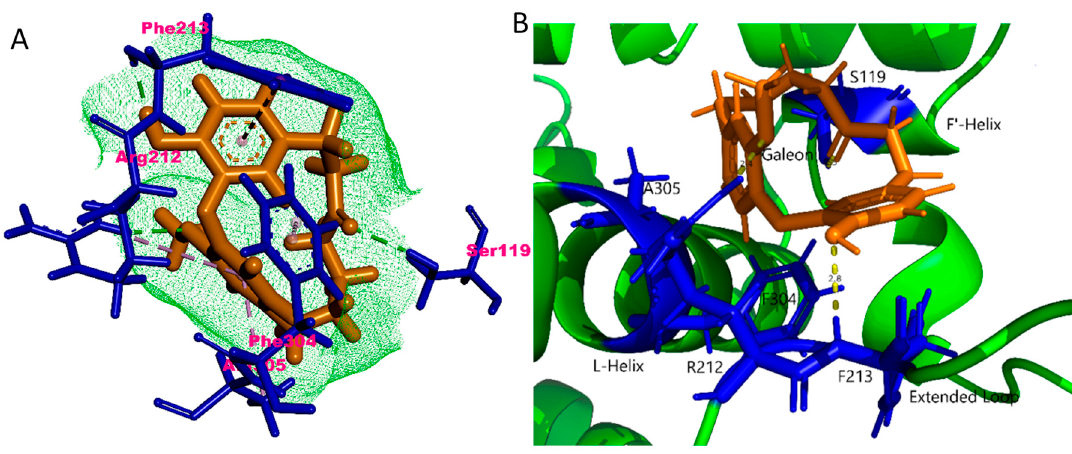
Figure 9. ( A ) 2D interaction mechanism of CYP3A4–galeon; ( B ) 3D interaction mechanism of CYP3A4–galeon.